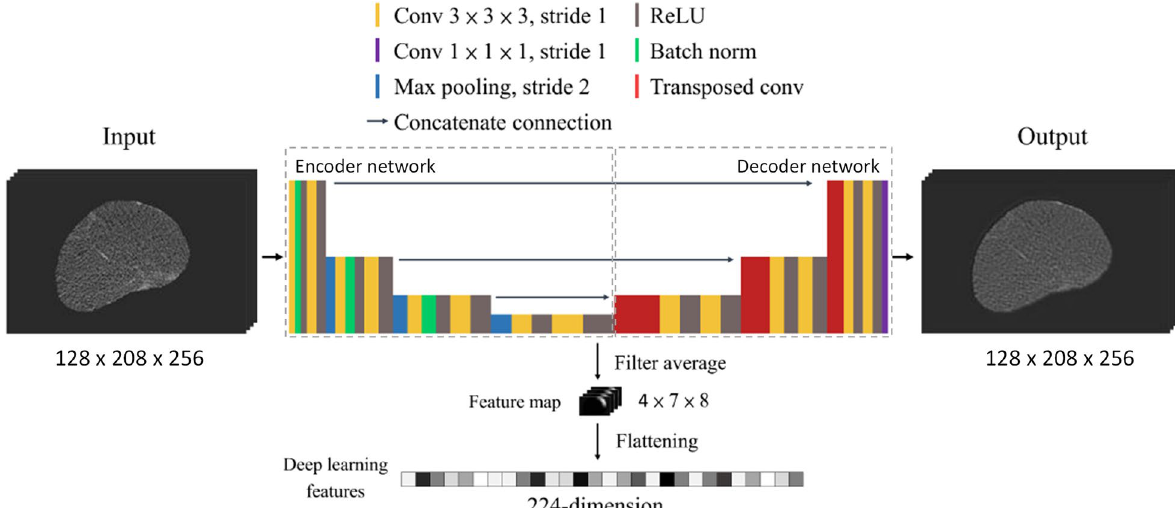
Fig. 3 The architecture of the 3D U‑net used for DL feature extraction. The architecture includes an encoder network and a decoder network. The encoder extracts tumor characteristics referred to as DL features, and the decoder uses the DL features to reconstruct original tumor image. The segmented tumor images were input into the network. The output of the last convolutional layer in the encoder network was extracted as